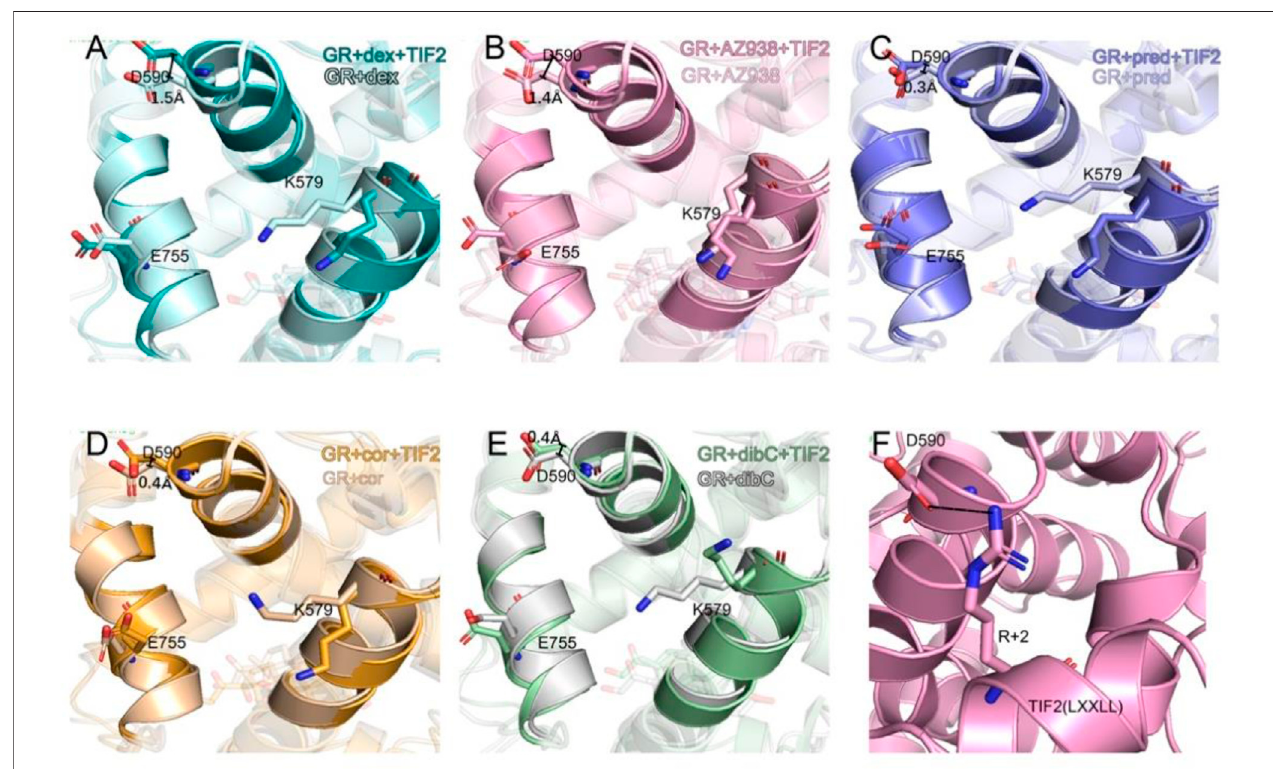
FIGURE 5 | Representative structures of the dex-bound system (A) , AZ938-bound system (B) , pred-bound system (C) , cor-bound system (D) , and dibC-bound system (E) .In each system, TIF2-bound and TIF2-unbound systems were aligned. Hydrogen bonds betweenD590 and R+2 areshown in (F) .The distance ofCBatom before and after the binding of TIF2 was